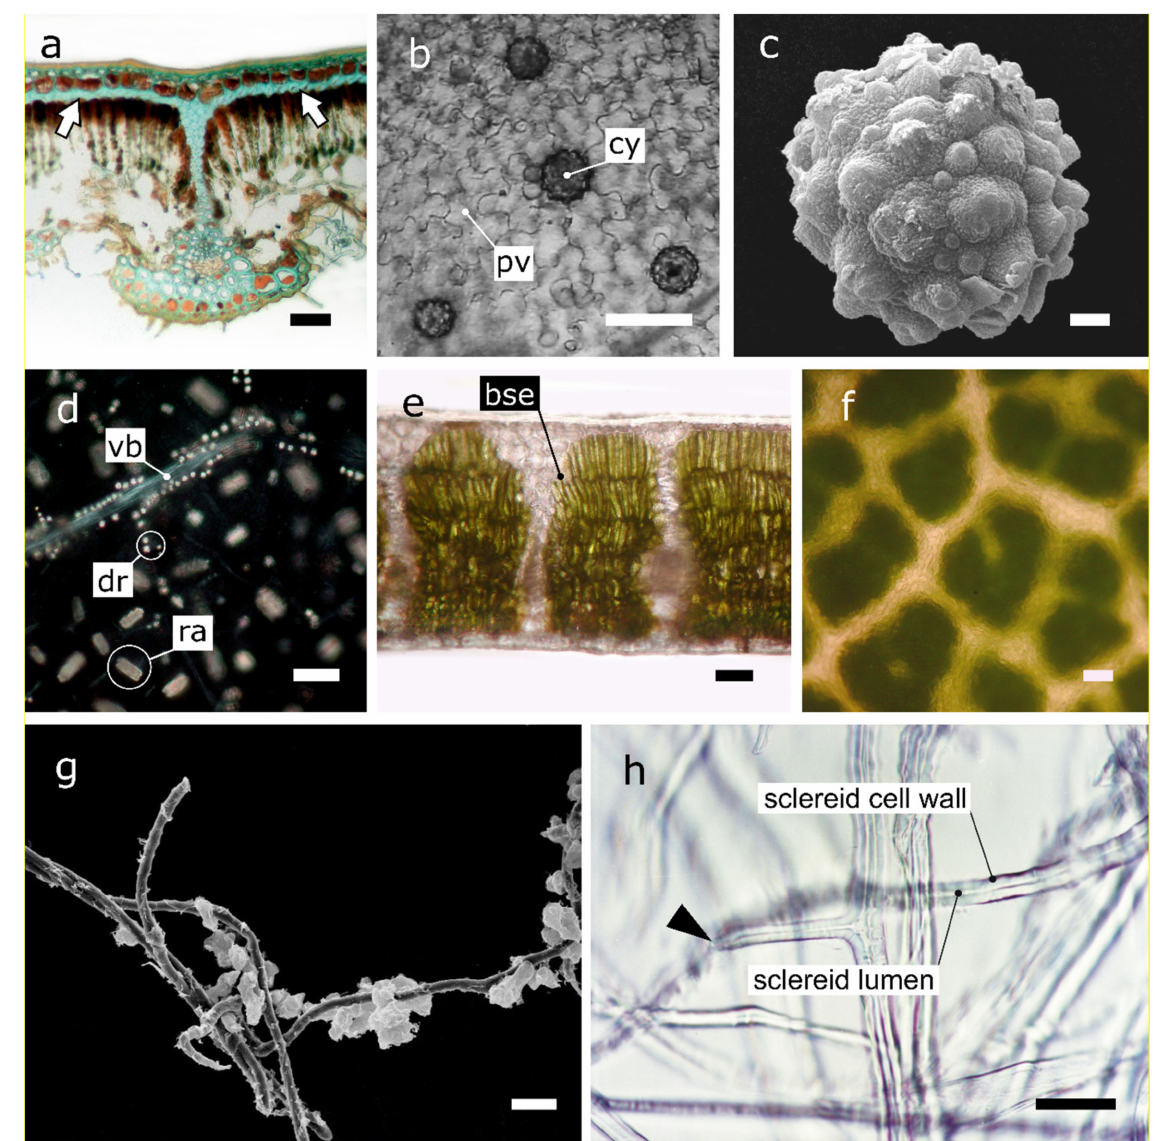
Figure 2. In planta or isolated mesophyll structural elements. ( a ) Light microscope cross section view of sclerified pseudohypodermis of a Banksia marginata leaf. Photograph kindly provided by Prof. G.J. Jordan; see also [86]. ( b ) Light microscope paradermal view of cystoliths (cy) of a Parietaria judaica leaf bleached with sodium hypochlorite solution. Pavement cells (pv) of the adaxial epidermis are also visible. Photograph reproduced from [95]. ( c ) Electron